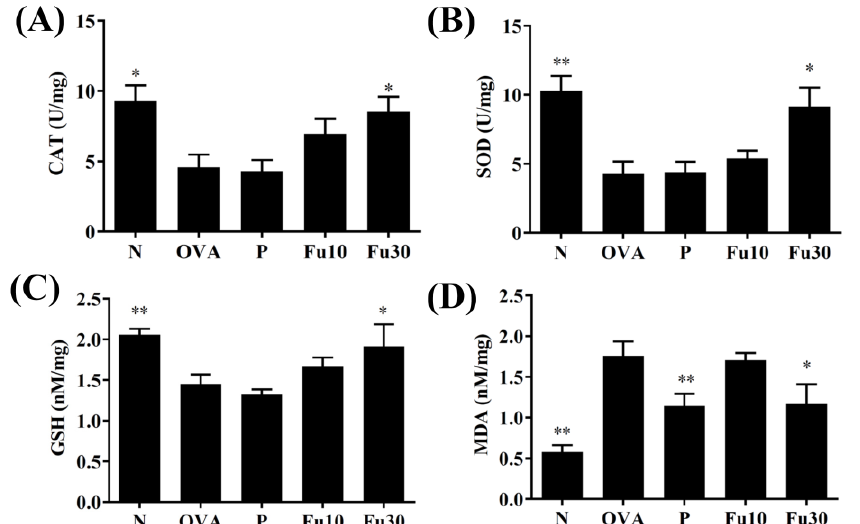
Figure 9. The effect of fucoxanthin (Fu) on oxidative stress factors. ( A ) CAT, ( B ) SOD, ( C ) GSH, and ( D ) MDA activity in the lung tissues from the mice. Three independent experiments were analyzed. Data are presented as mean ± SEM. * p < 0.05, ** p < 0.01 compared to the OVA control group. 10 mg/kg and 30 mg/kg fucoxanthin were named as Fu10 and Fu30, respectively. 5 mg/kg prednisolone was named as P.